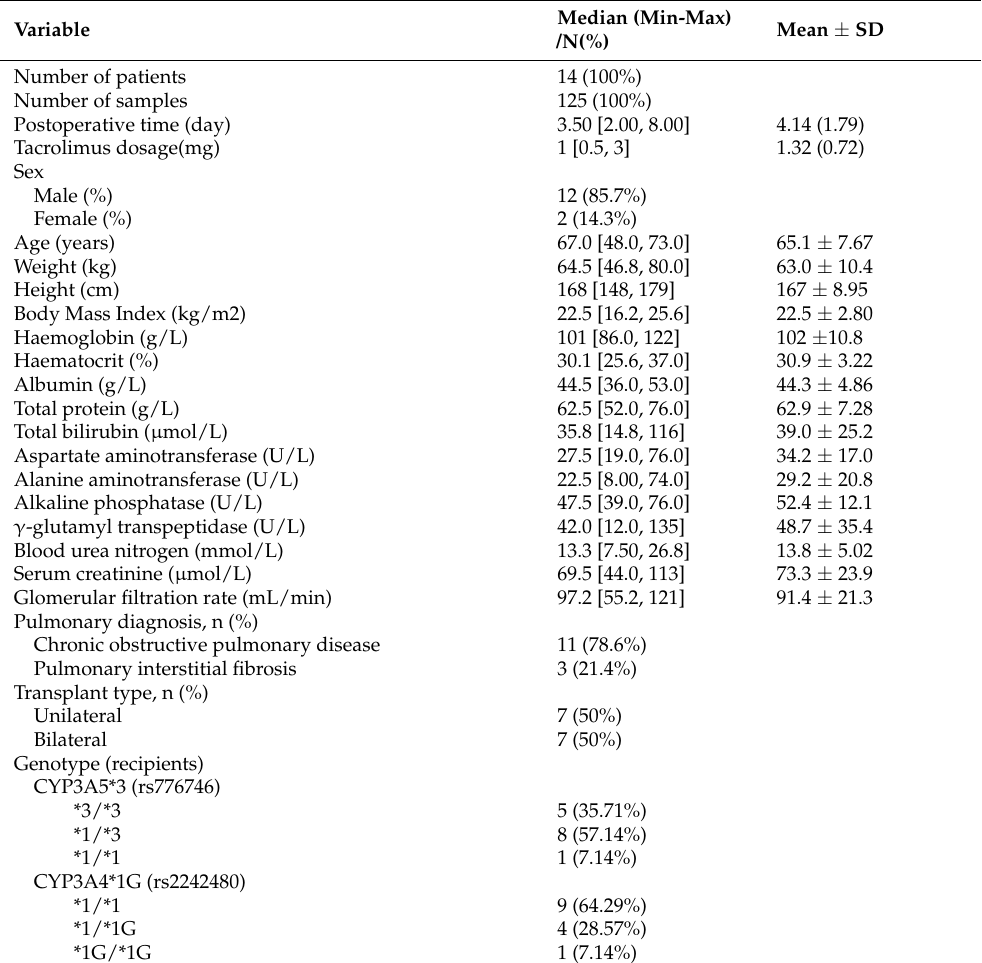
Table 1. Patient characteristics.